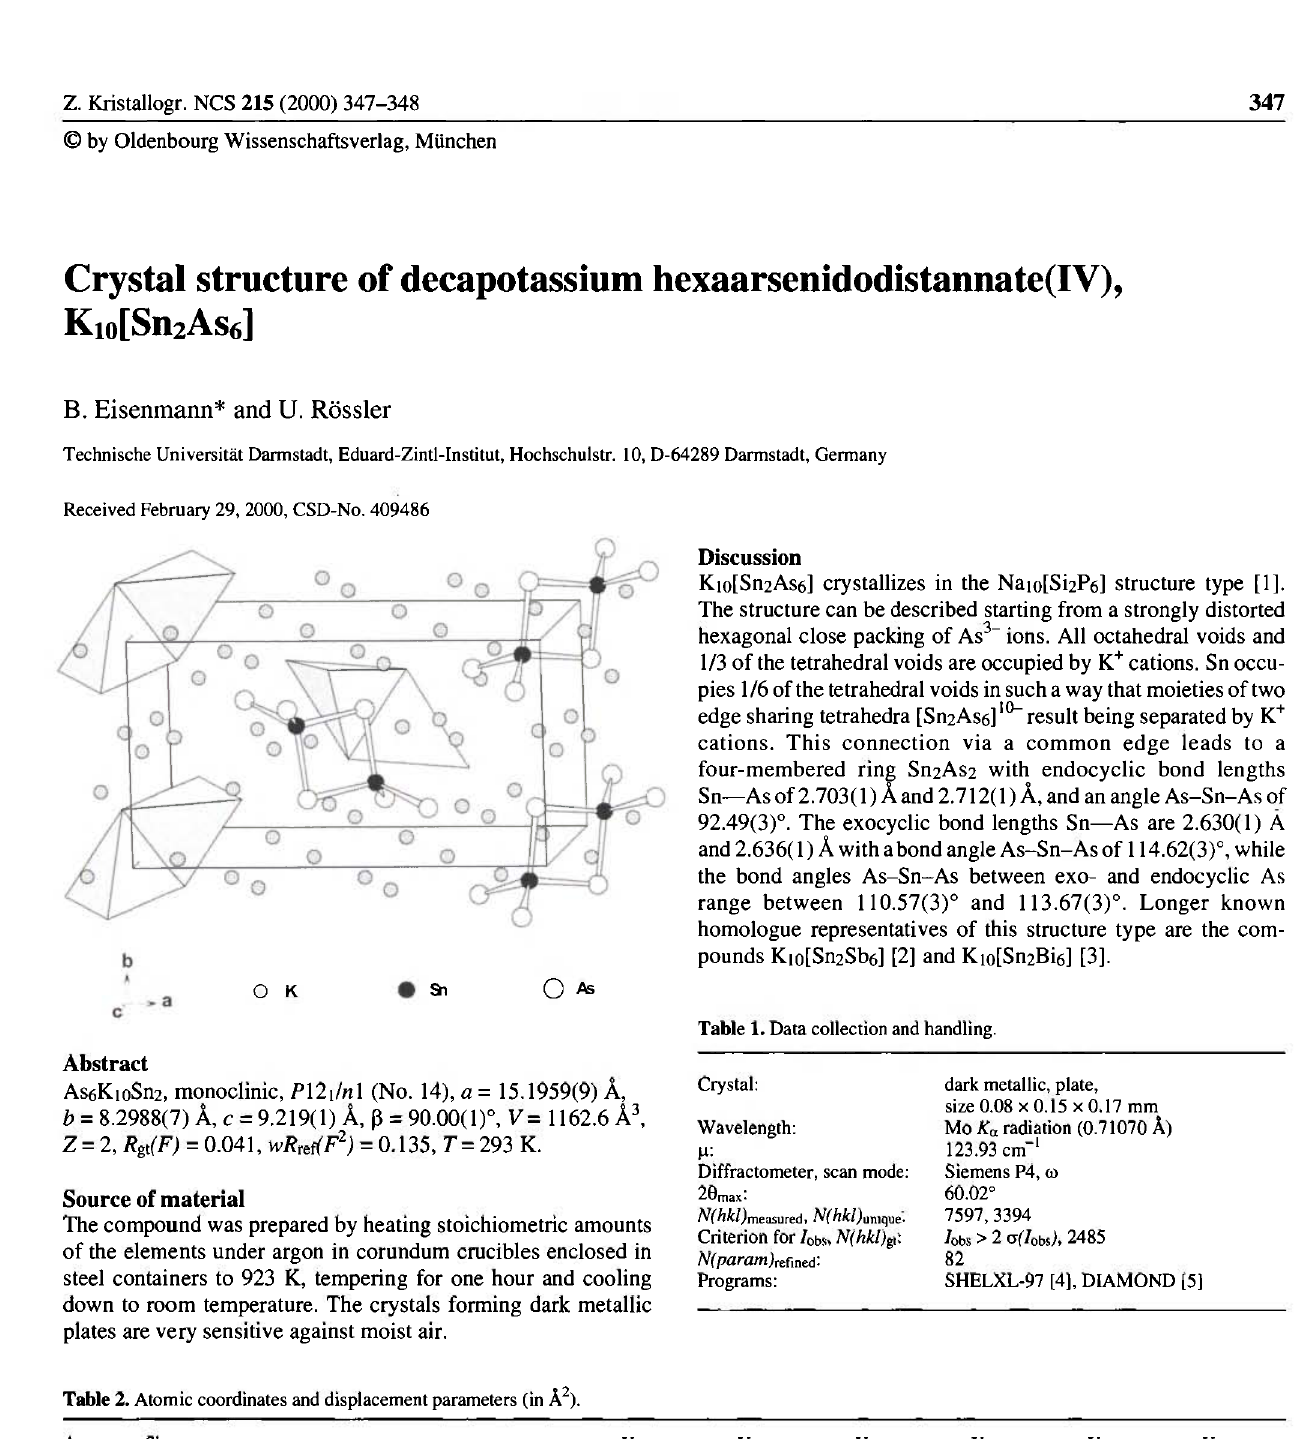
Table 2. Atomic coordinates and displacement parameters (in Ä 2